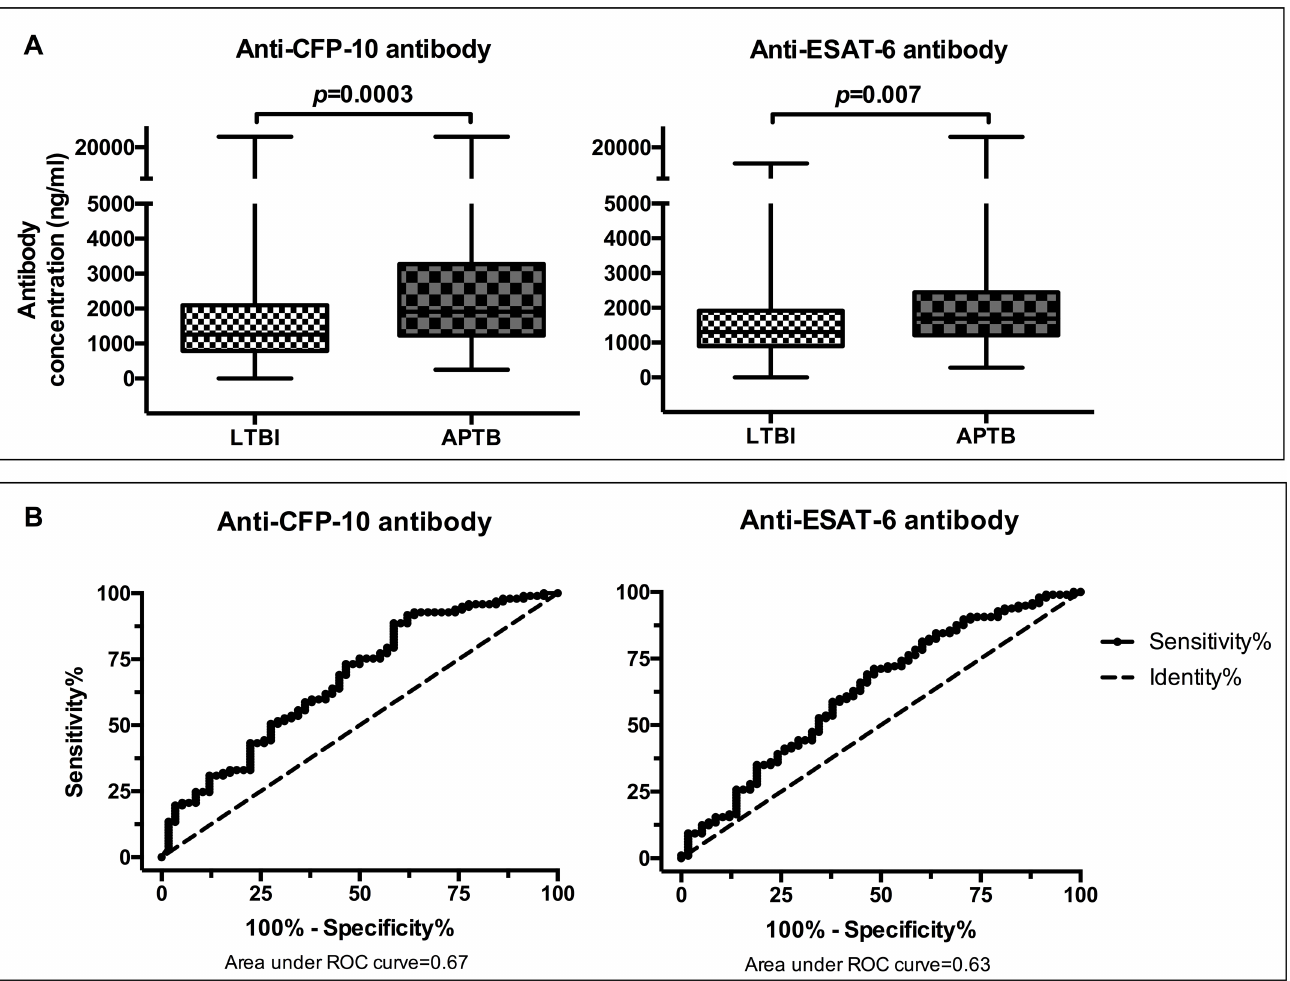
Fig 3. CFP-10 and ESAT-6 specific antibodies in QFT-GIT nil control supernatants from APTB cases & individuals with LTBI and their discriminatory potential. Panel A: box and whisker plots showingdifferences in antibodies betweenthe two groups. Panel B: Receiver operator characteristic curves showingdiscriminatory potentialat different antibody cut-offs.